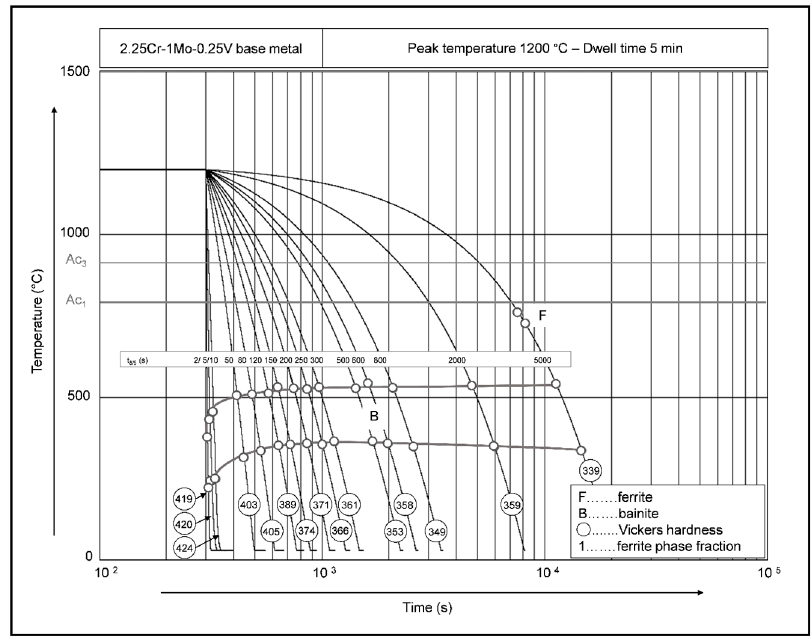
Figure 13. CCT diagram for the base metal with a peak temperature of 1200 ◦ C and a dwell time of 5 min.